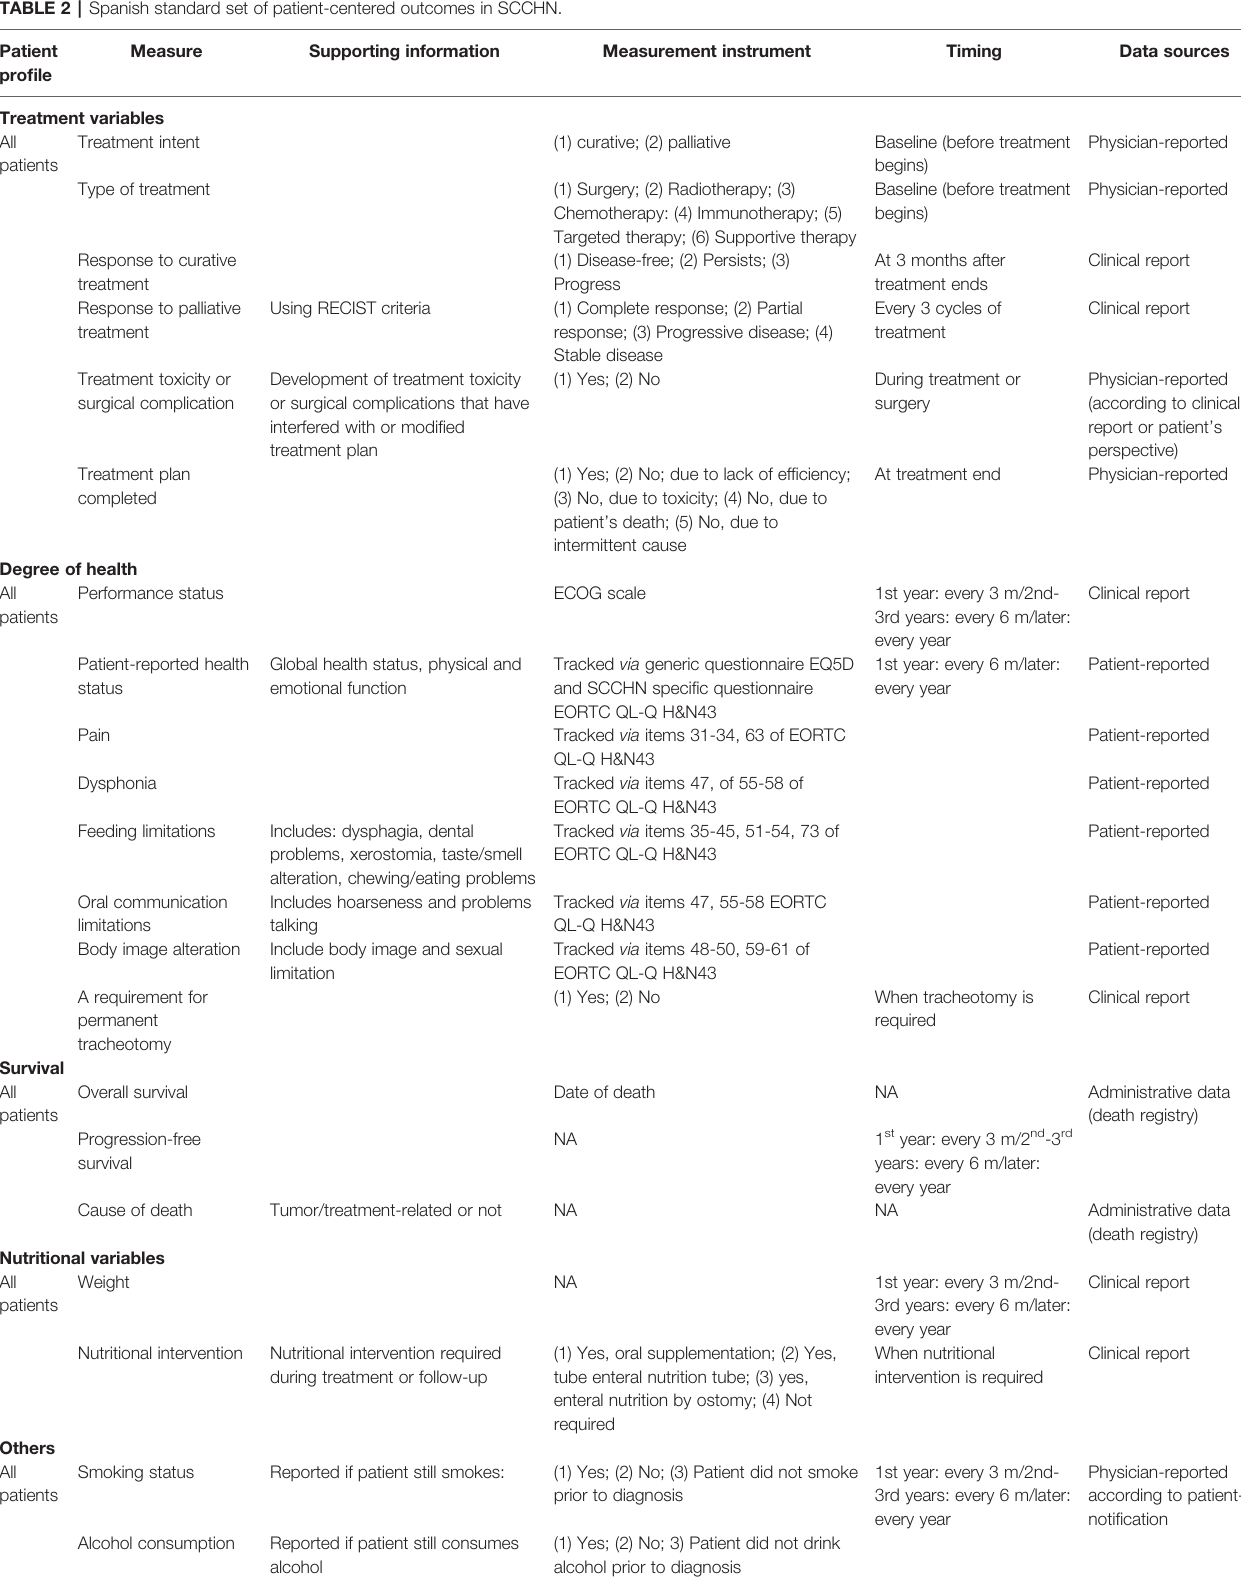
TABLE 2 | Spanish standard set of patient-centered outcomes in